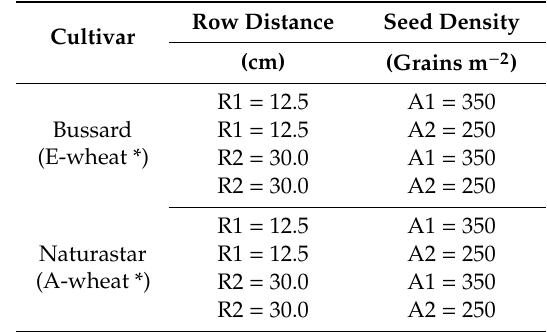
Table 2. Applied cultivars, row distances, and seed densities in the field trials.